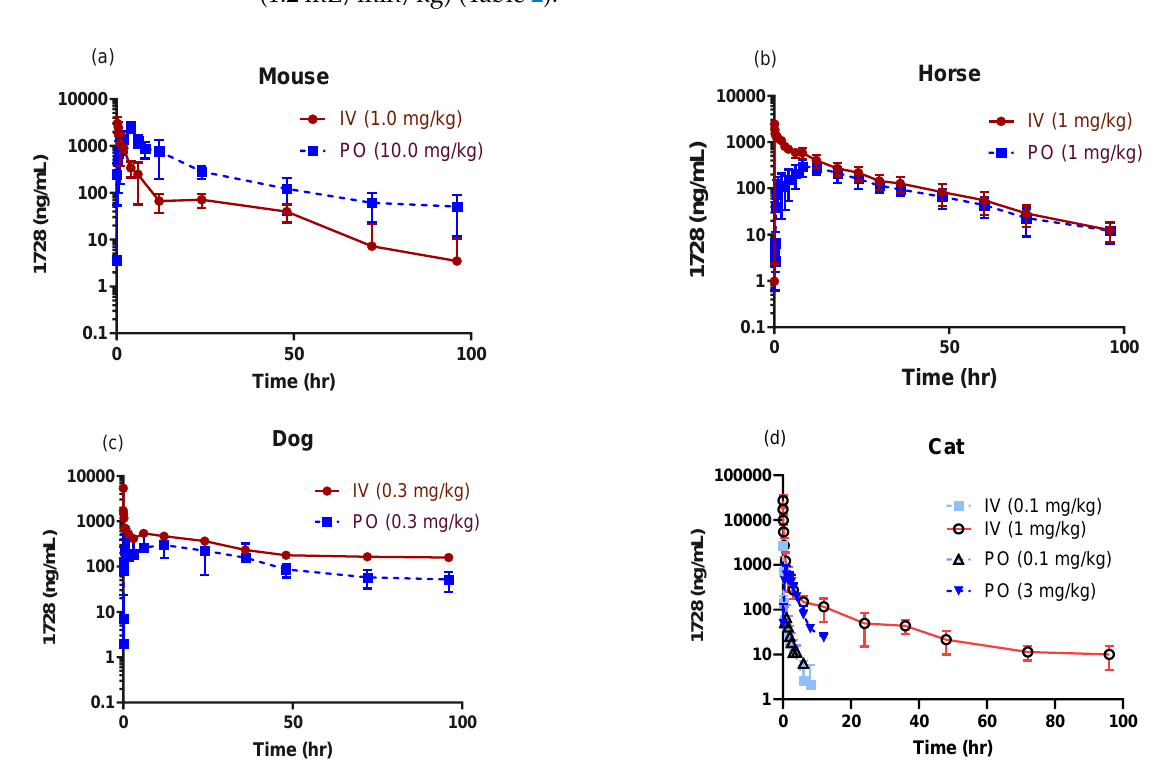
Figure 1. General overview of PK profiles of EC1728 represented as semi log-linear plots of concentrations (mean ± STDEV) after dosing IV or PO in mice ( n = 4) ( a ), horses ( n = 8) ( b ), dogs ( n = 5) ( c ) and cats ( n = 3 − 6) ( d ). T last in cats at 0.1 mg/kg IV and PO was 8 h for IV and 12 h for PO; however, the C last in the low dose cat group dosed IV was observed at 3 h and 4 h for PO. Linear representation of graphs through 12 h are plotted in Supplementary Figure S1. Table 2. Summary of key PK parameters between species.